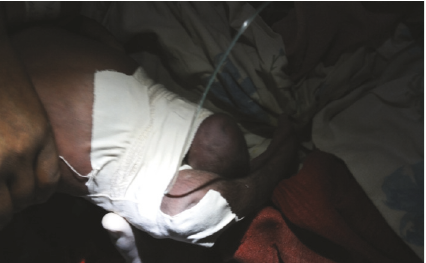
Figure 3: Picture of the newborn with Foley catheter in place and legs strapped.